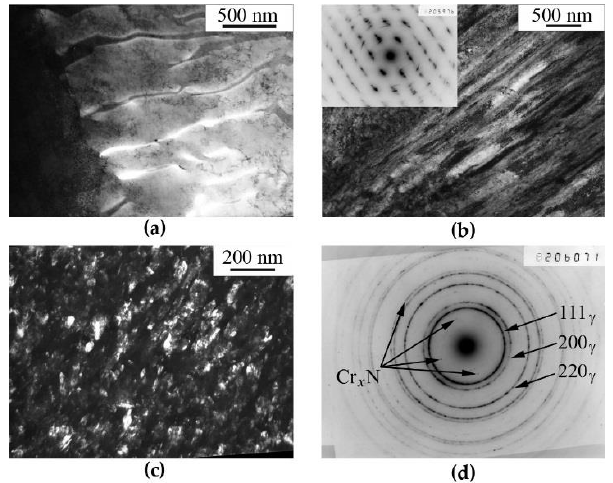
Figure 2. Structure of ( a ) aged and ( b , c ) deformed FeMn 22 Cr 18 N 0.83 steel. Treatment: ( a ) quenching + aging at 1073 K, 2 h; ( b ) aging + HPT of n = 3 rev. at 298 K; ( c ) aging + HPT of n = 3 rev. at 573 K. ( a , b ) — Bright-field images, ( c ) — dark- field images in the combined reflection (111)γ + (200)γ + Cr 2 N. Electron-diffraction pattern ( d ) corresponding to the image ( c ).